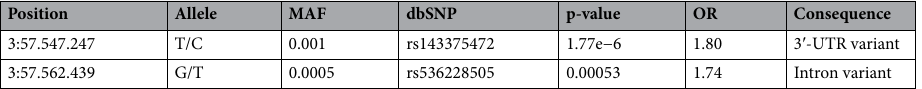
Table 2. SNPs close to PDE12 that were associated with type 1 diabetes. SNPs close to the PDE12 gene that were associated with the development of T1D were identified at two positions within the